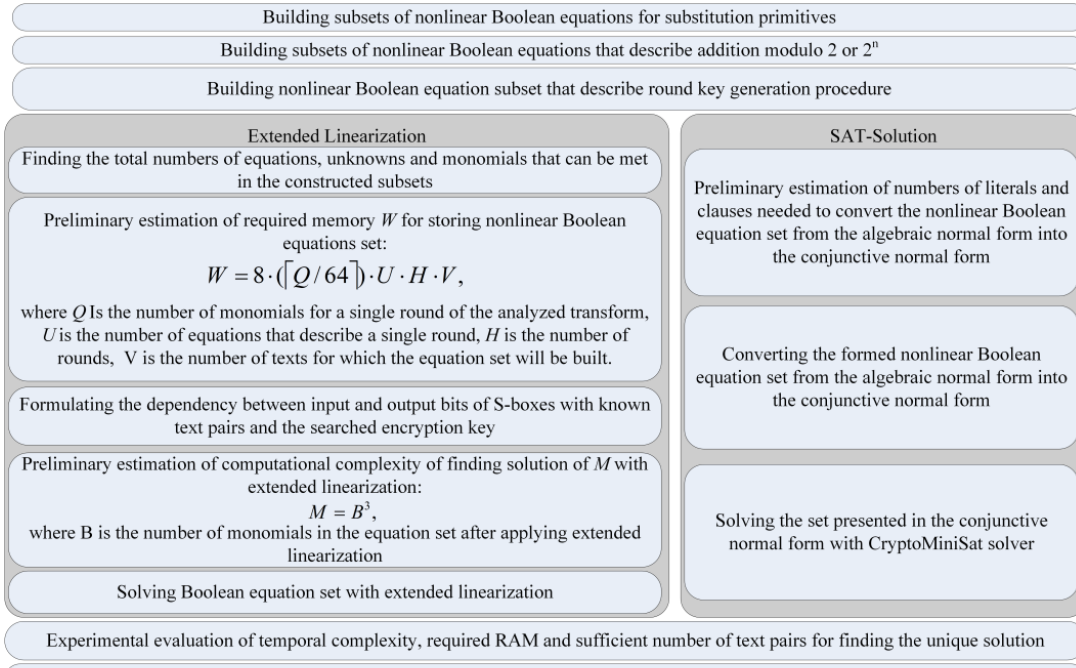
Table 5. Algebraic analysis of Magma.